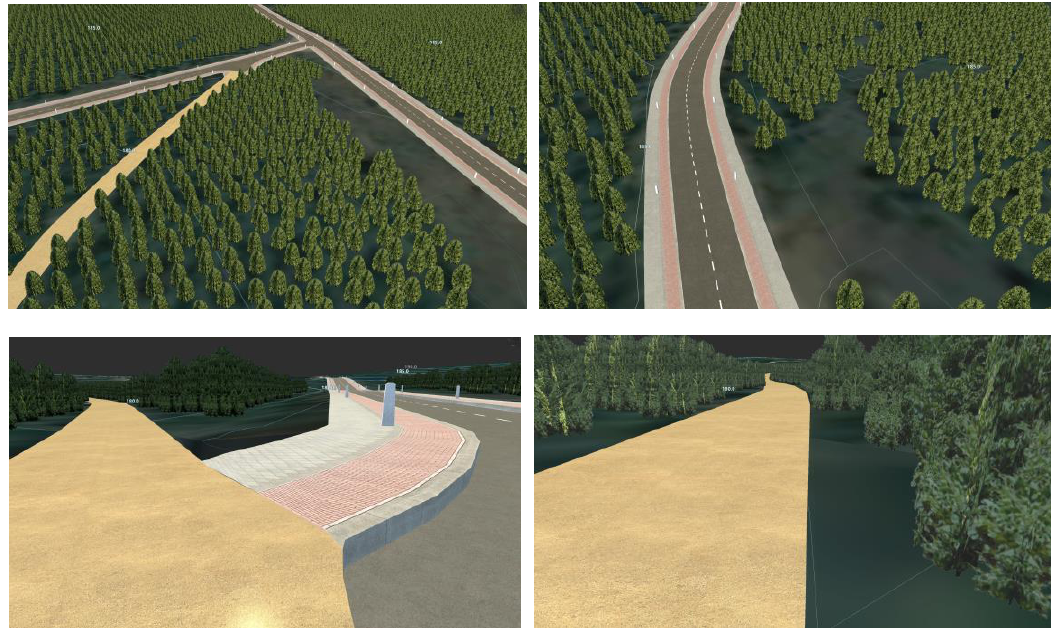
Figure 15. Some images of vegetation detected from LiDAR data classification added as a parametric object in AIF.